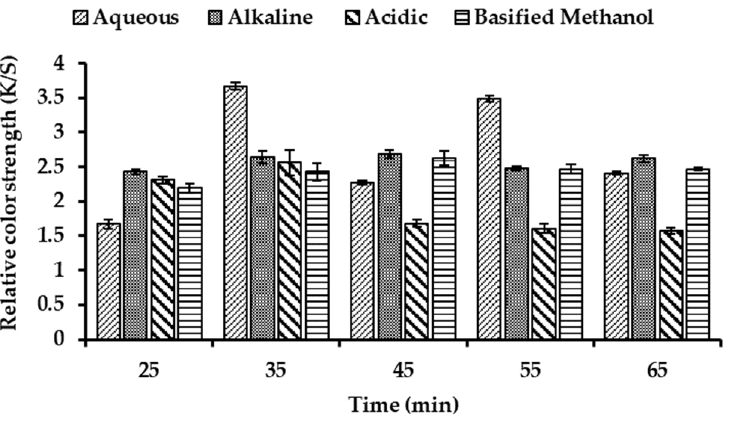
Figure 6. Dyeing of wool with rose extract for different durations.